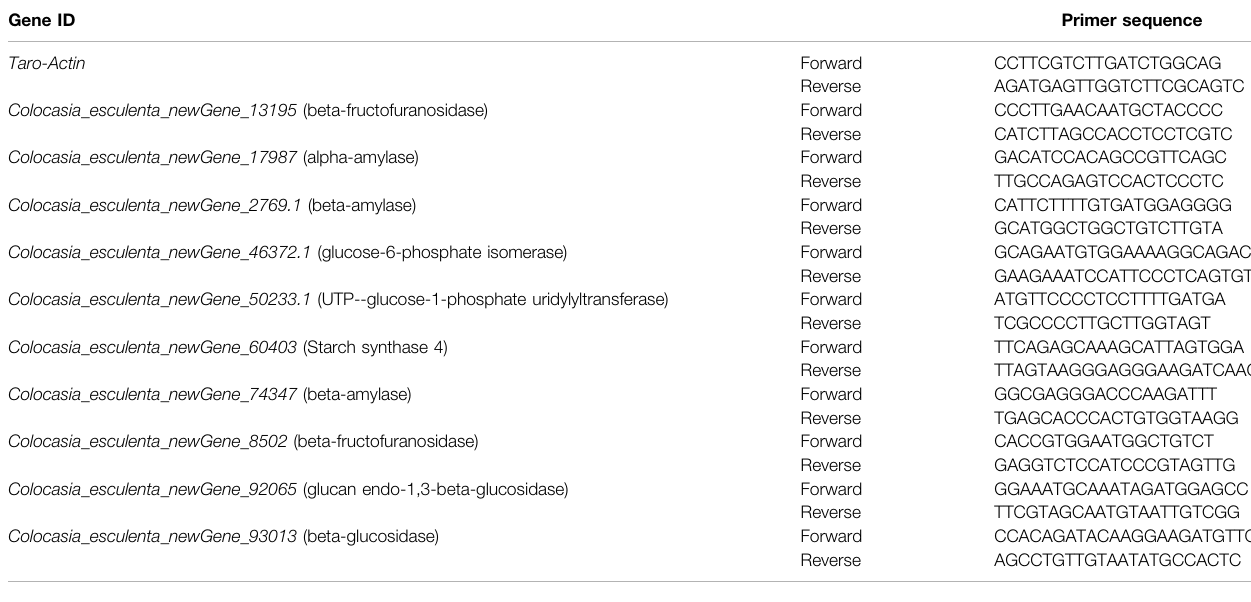
TABLE 1 | List of primers used for qRT-PCR analysis. Gene